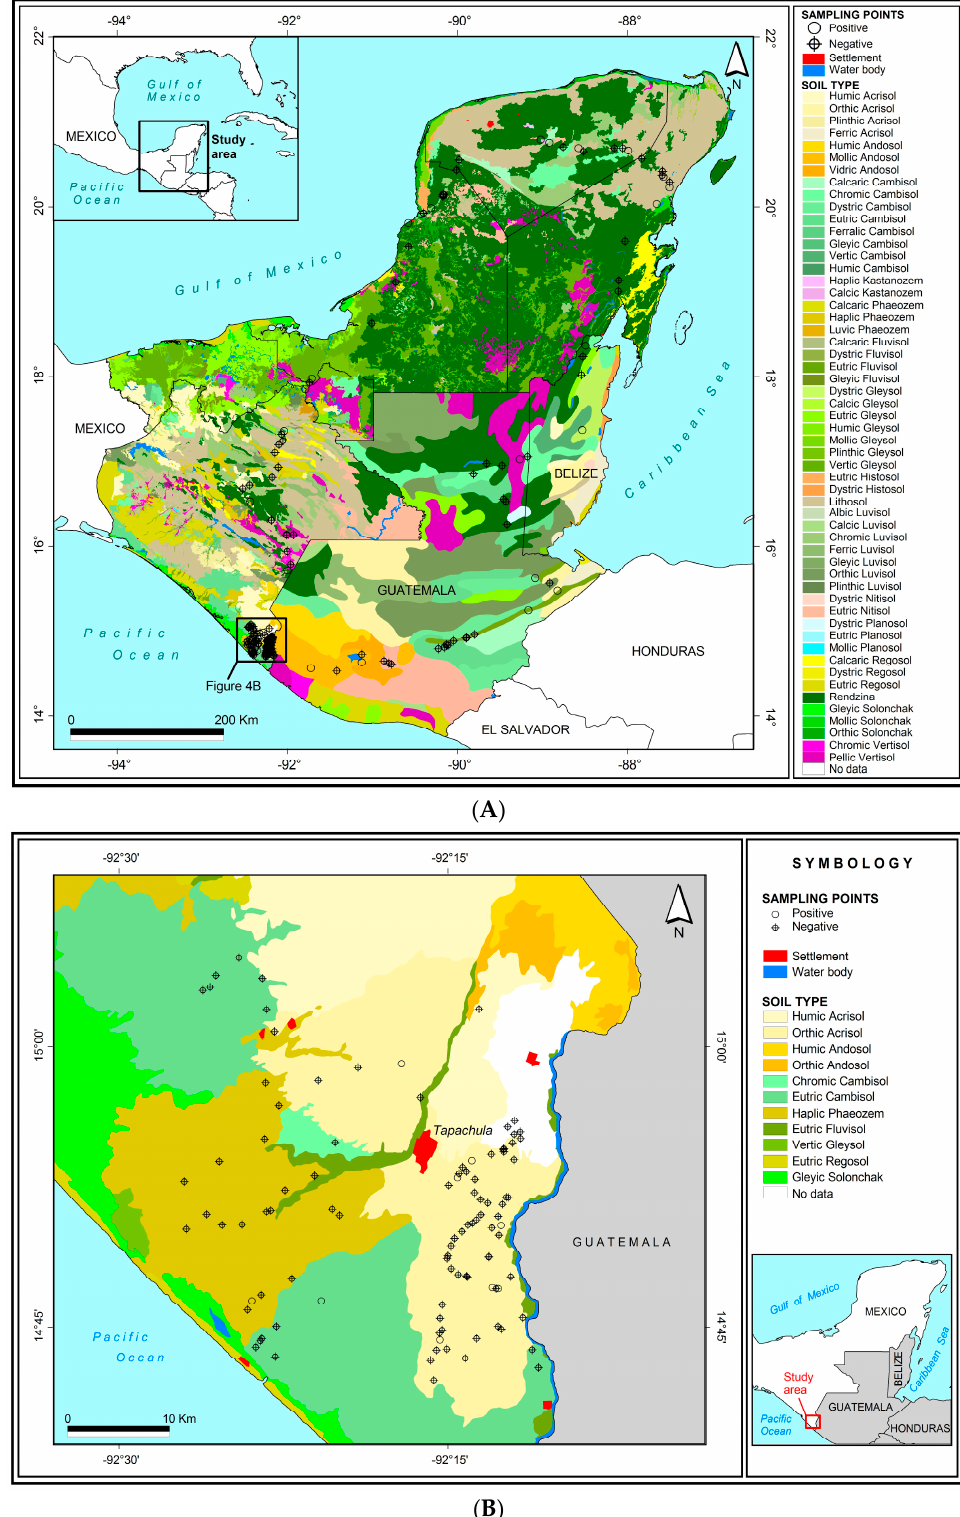
Figure 4. Soil type composite maps for ( A ) southern Mexico, Belize, and Guatemala and ( B ) the Soconusco region of Chiapas State, Mexico. Georeferenced soil samples were plotted as OB-positive samples (open black circles) and OB-negative samples (black circles with a cross). High resolution versions of these maps are available as Supplemental Material (Figures S1 and S2).